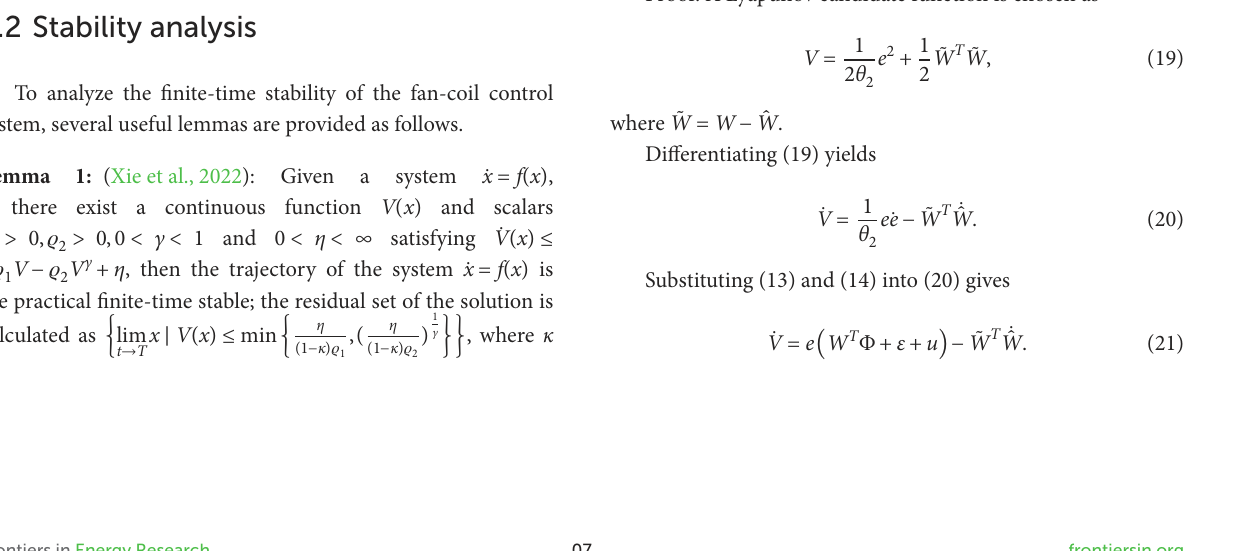
FIGURE 14 Control input without NN compensation.